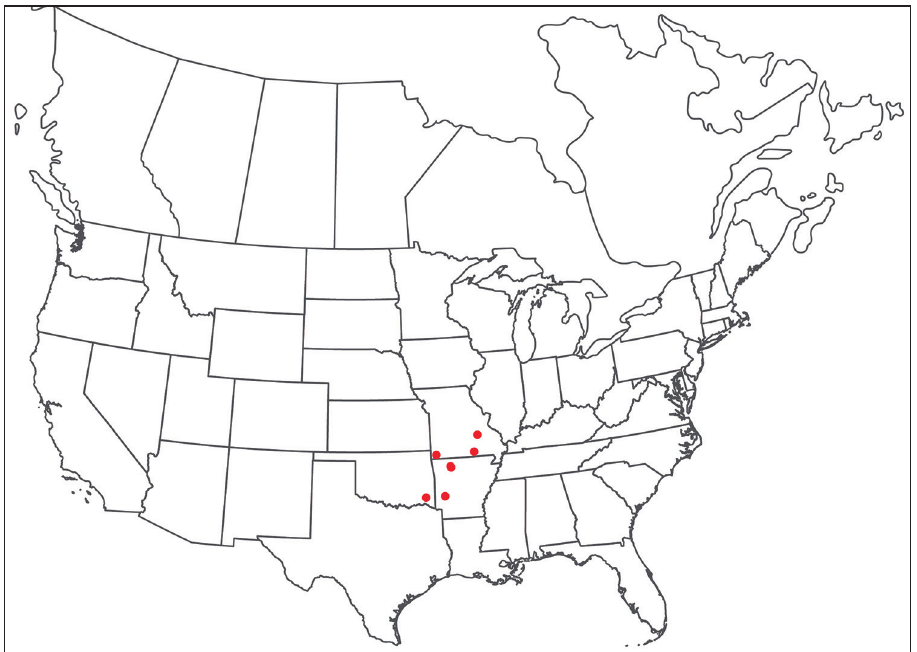
Figure 184. Torrenticola pearsoni sp. n.